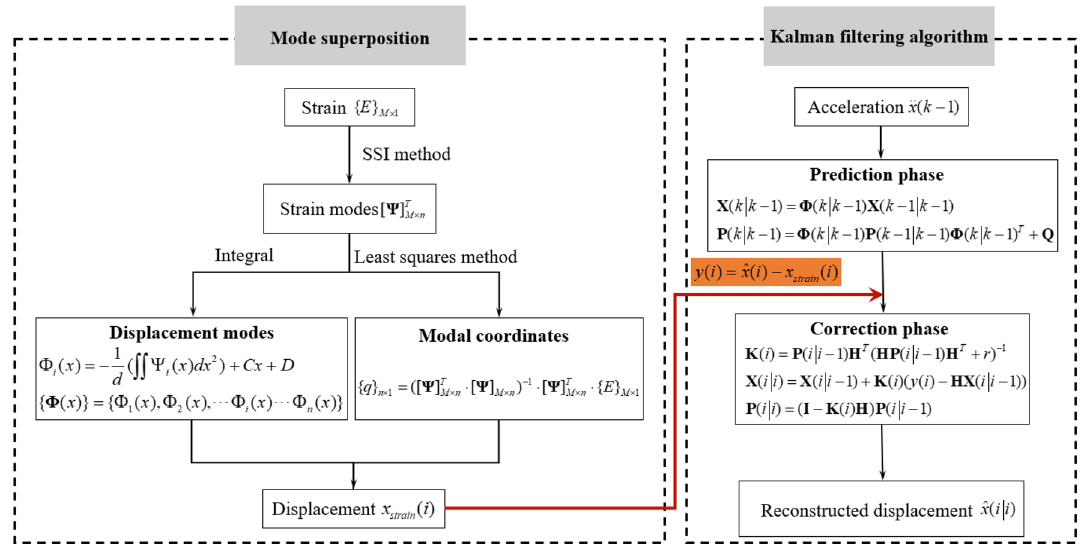
Figure 1. Flow chart of multi-rate data displacement reconstruction